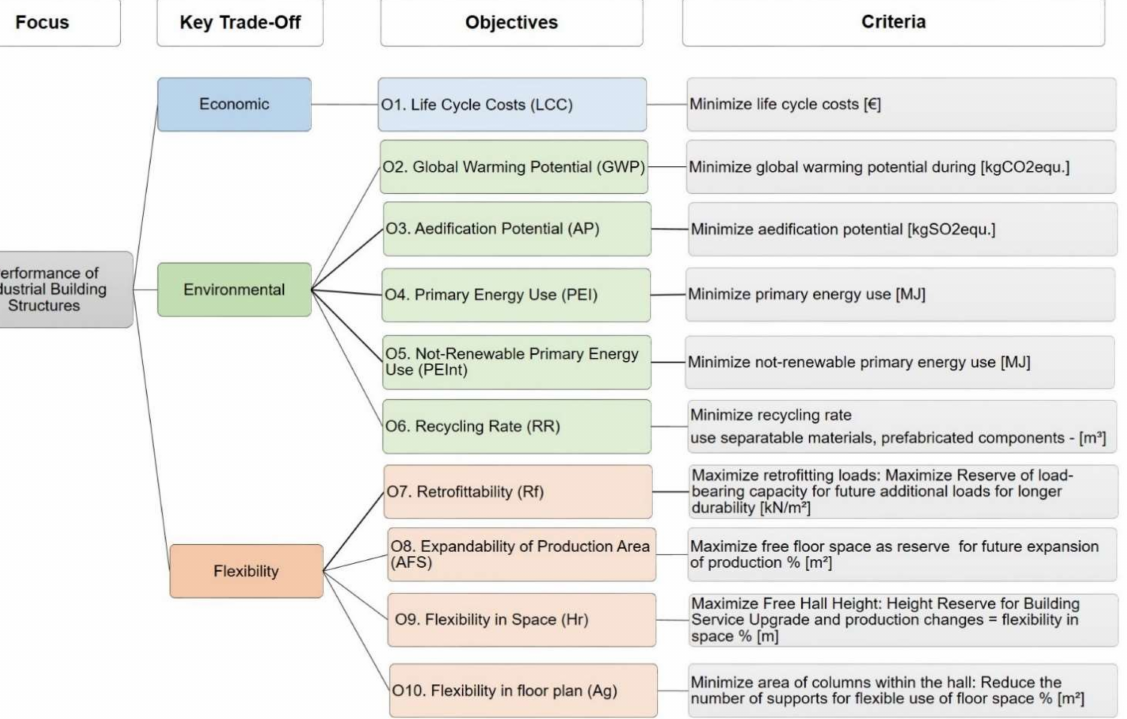
Figure 4. Key trade-offs and related objectives included in the POD model framework for performance assessment of industrial building